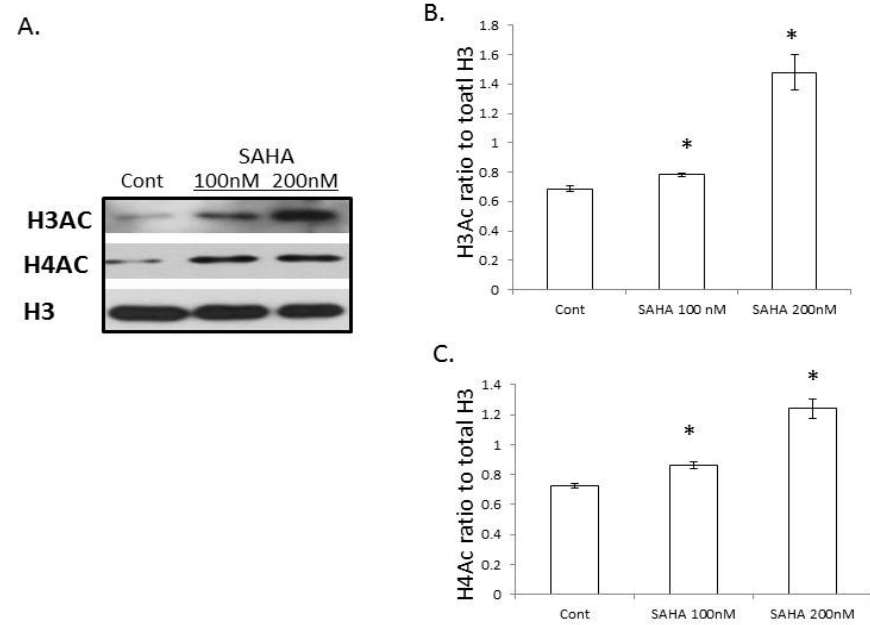
Figure 3. Acetylation of histone H3 and H4 in IPF fibroblasts with or without SAHA treatment. ( A ) Western blots of total acetylated histone H3 and H4 in IPF